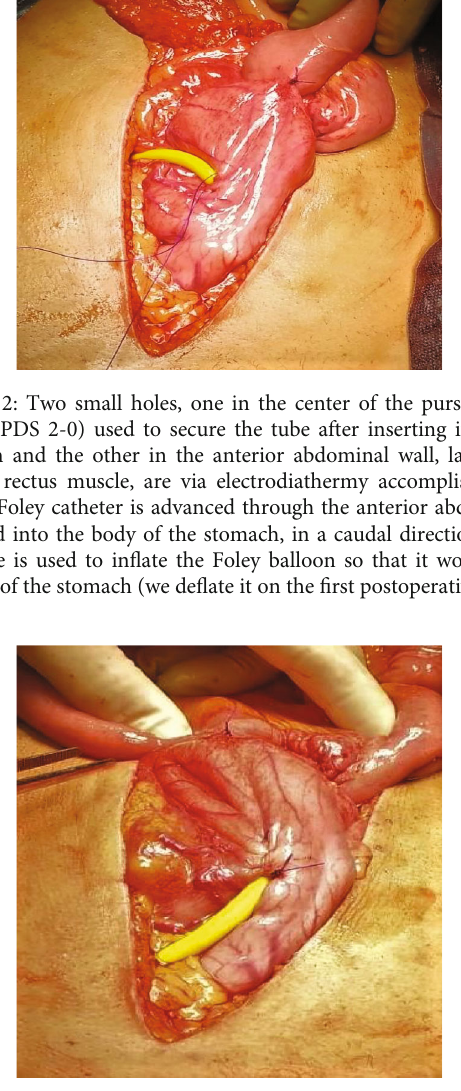
Figure 3: A serosa-lined tunnel (Witzel canal) is created with a continuous suture of the same 2-0 PDS used at the beginning.